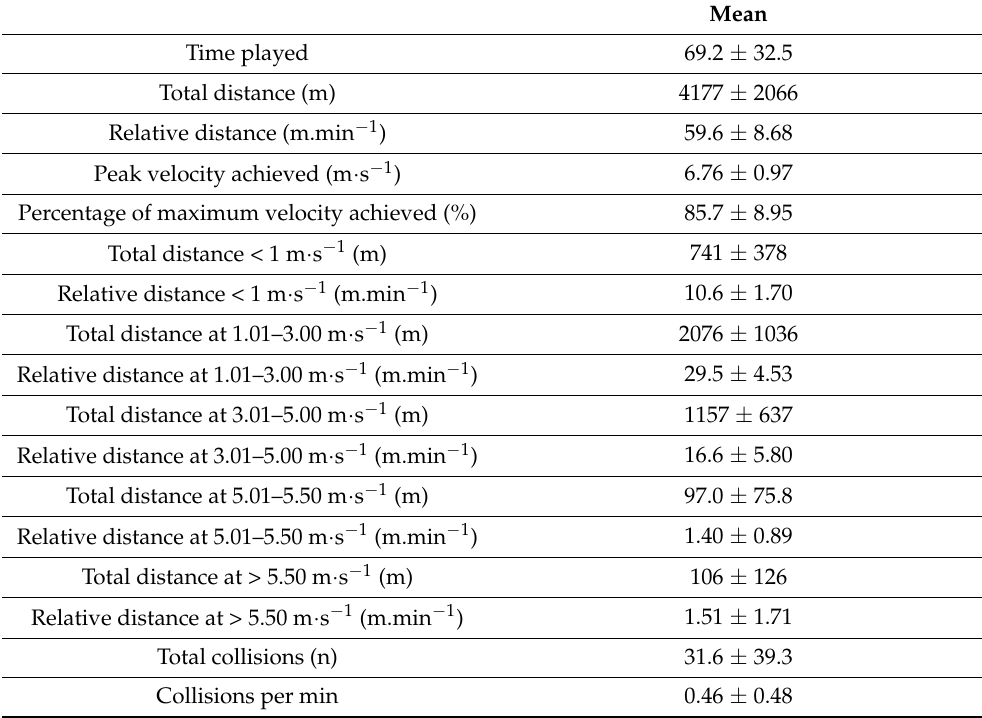
Table 1. Physical match demands of match play for a squad of international female rugby union players during three consecutive years of the Women’s Six Nations Championship.